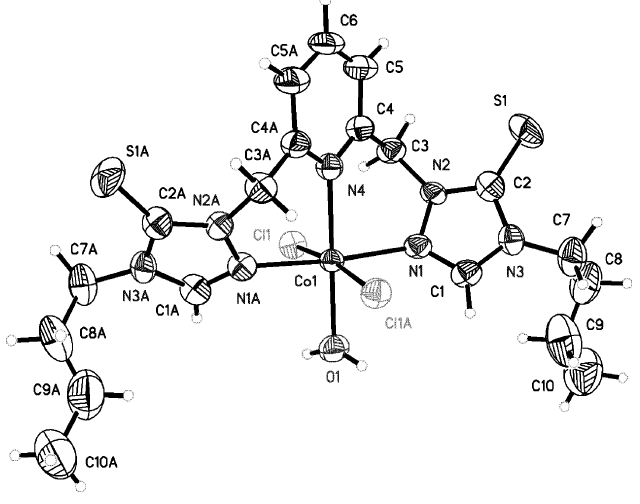
Figure 3 A view of the molecular structure of C 19 H 29 Cl 2 CoN 7 OS 2 , 8 , showing the atom-labeling scheme and displacement ellipsoids drawn at the 30% probability level. The molecule crystallizes in the C 2/ c space group with a twofold rotation axis perpendicular to a c -glide plane along the center of the pincer ligand through to the metal ion transforming the two asymmetric units into the complete complex and containing four cobalt(II) complexes per unit cell. Atoms with the suffix A are generated by the symmetry operation 1 (cid:3) x , y , (cid:3) z + 1 . 2